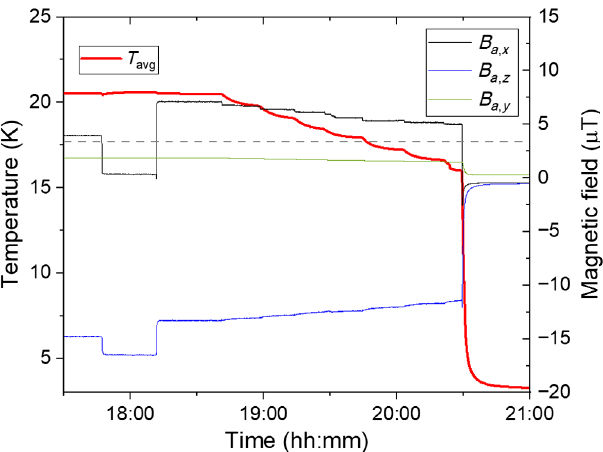
FIG. 27. T and B along three orthogonal directions at the a avg cavity equator during the third cooldown for which the cavity temperature was controlled by adjusting the power to heaters 5 – 7. The heaters location is shown in Fig. 20. The dashed line is ∼ 17 . 7 at T c